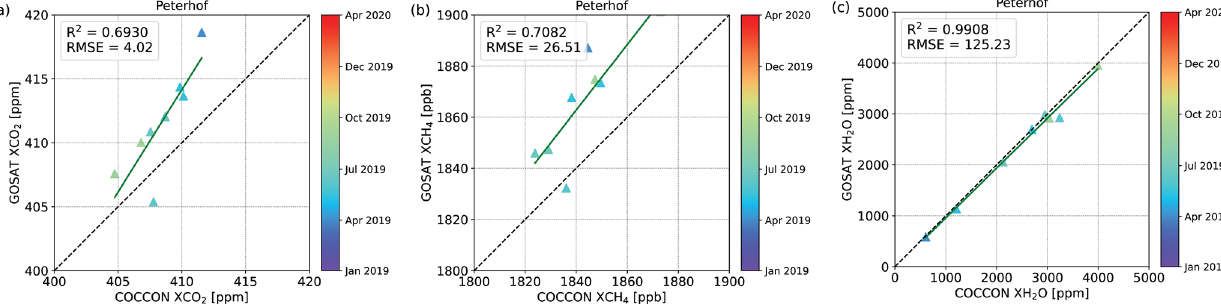
Figure 12. Correlation plots between GOSAT and COCCON for (a) XCH 4 , (b) XCO and (c) XH 2 O at Peterhof. All satellite data except